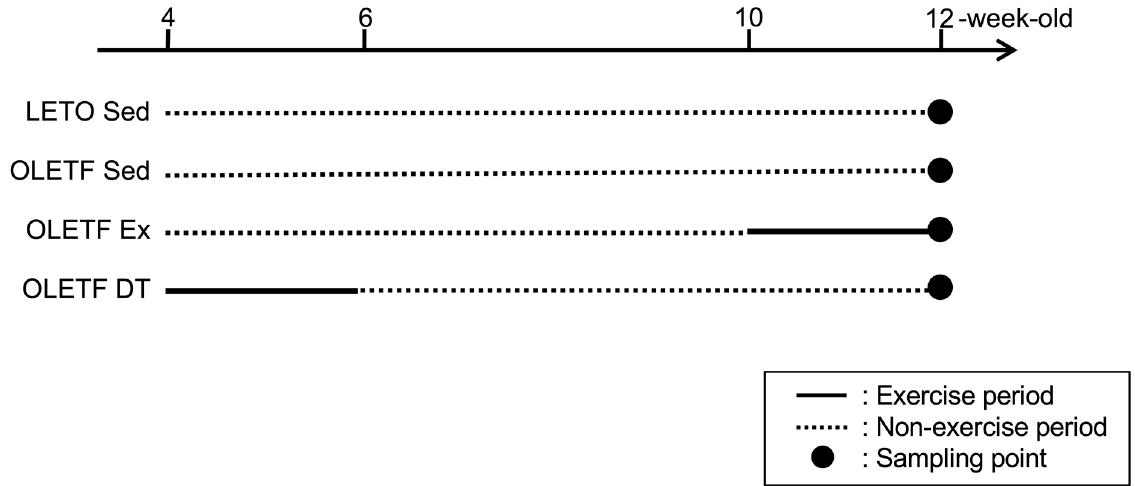
Figure 4. Experimental design. LETO Sed, LETO non-exercise sedentary; OLETF Sed, OLETF non-exercise sedentary; OLETF Ex, OLETF non-exercise from 4- to 10-weeks-old and exercise from 10- to 12-weeks-old; OLETF DT, OLETF exercise from 4- to 6-weeks-old and detraining from 6- to 12-weeks-old. Dark circles indicate the point of tissue sampling. Solid and dotted lines indicate exercise and non-exercise periods, respectively. Tissue samples were collected at 6- ( n = 3 in the LETO Sed, OLETF Sed, and OLETF DT groups) or 12 ( n = 6 in each group)-weeks-old. Tissue samples at 6-weeks-old were used to confirm the development process of BAT whitening (data not shown).